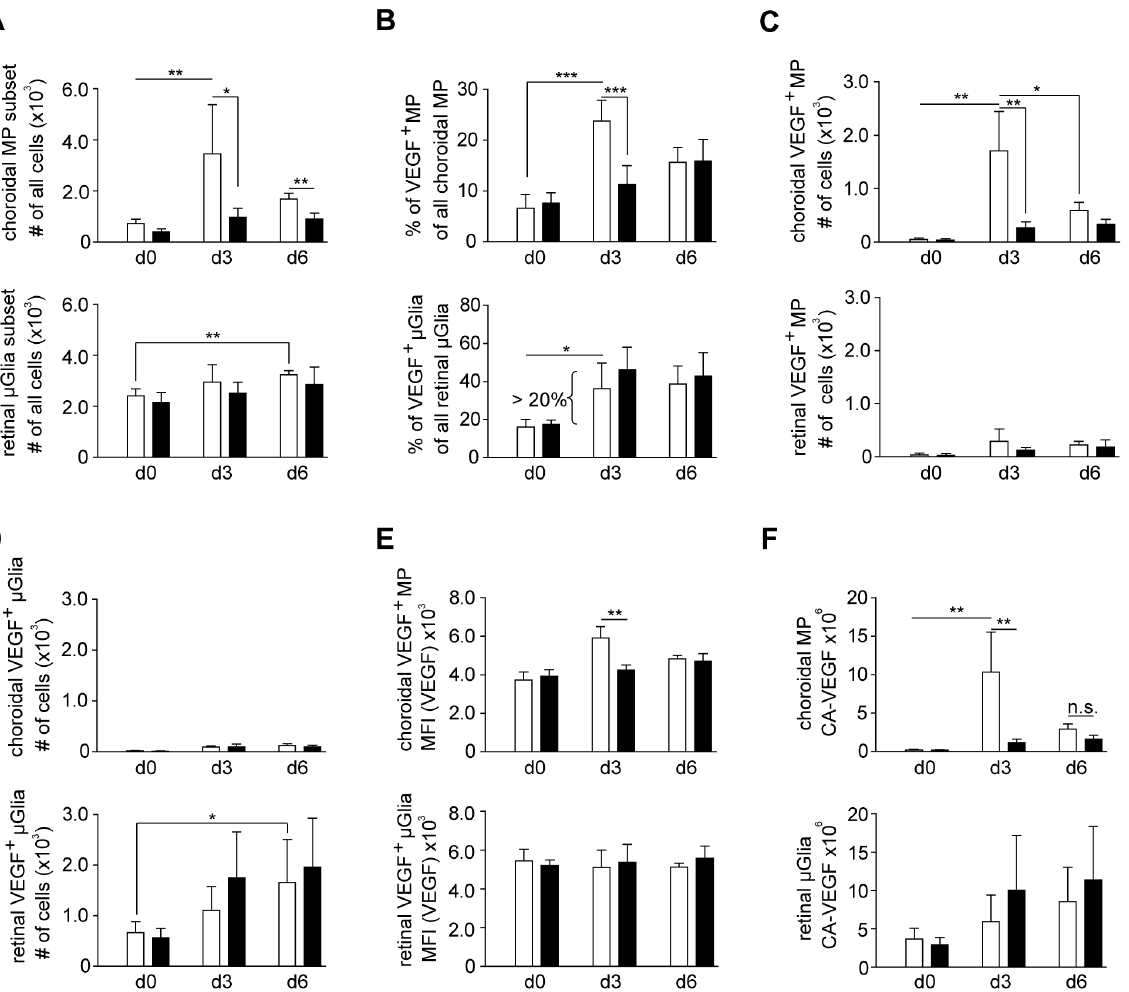
Figure 4. Laser-induced VEGF content by choroidal MPs, but not by retinal microglia cells is CCR2-dpendent. (A) Total numbers of choroidal macrophages (MP) (CD45 hi CX 3 CR1 lo ) and microglia cell ( m Glia) (CD45 l u CX 3 CR1 hi ) in CCR2-competent (white bars) or –deficient (black bars) mice before or 3 or 6 days after laser treatment. (B) The percentage of VEGF + cells in the MP and m Glia subset were. (C, D) numbers of VEGF + choroidal MP (C) and (D) VEGF + retinal m Glia. (E, F) VEGF-expression as mean fluorescence intensity (MFI) (E) and calculated amount of VEGF (CA-VEGF) per choroidal MP and retinal m Glia (MFI) (F). Bar graphs show means 6 SD. Comparisons of cell numbers were performed using t test (A– D). MFI and CA-VEGF were analyzed by the two-tailed nonparametric Mann-Whitney-U-Test (E,F). The statistical significance was analyzed as indicated (* , 0.05, ** , 0.01, *** , 0.001). Two-way analysis of variances (two-way ANOVA) depicted significant differences (***p , 0.001) for MP but not m Glia numbers in comparison of CCR2-competent and deficient reporter mice. A total of 3–5 mice per group were analyzed in 2 independent